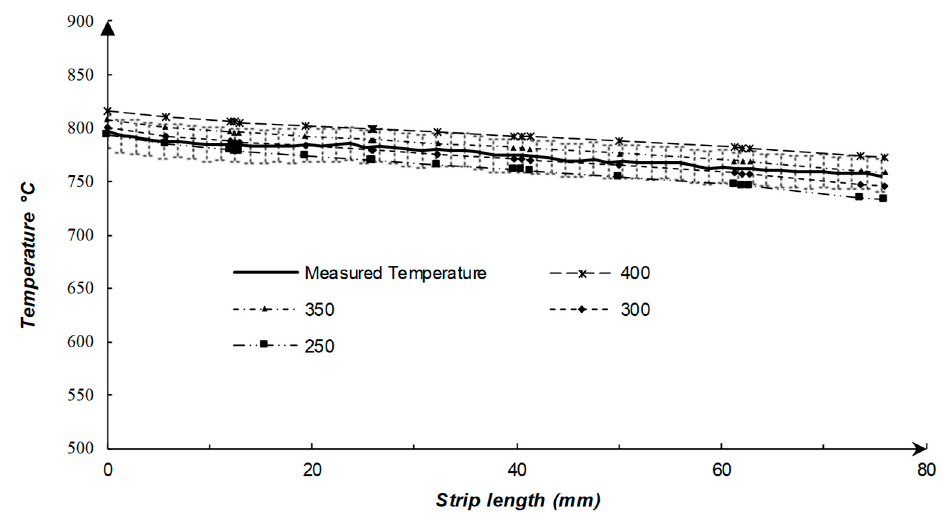
Figure 6. Validation of assumed boundary condition for the bath temperature.